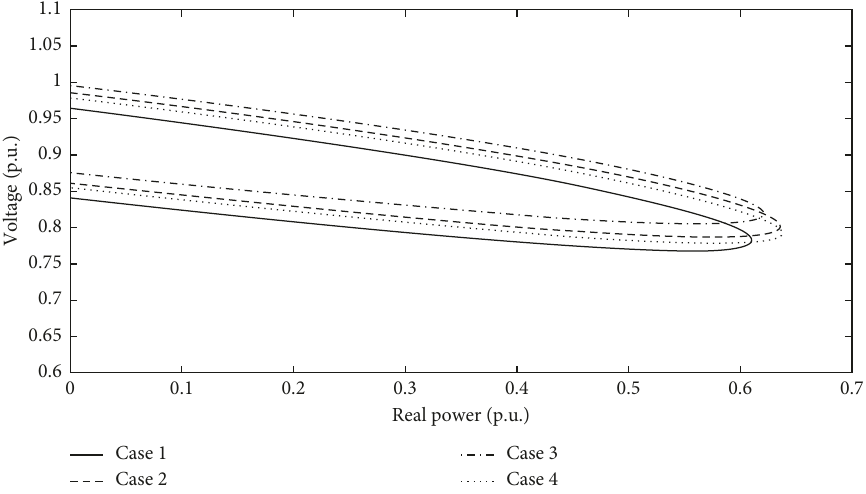
Figure 7: PV curves at the weakest bus of the IEEE 57-bus test system.